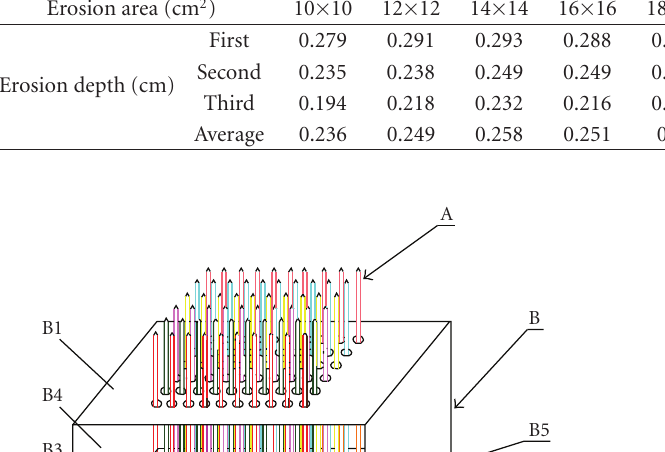
Table 1: The data of di ff erent erosion areas recorded in field. Erosion area (cm 2 )